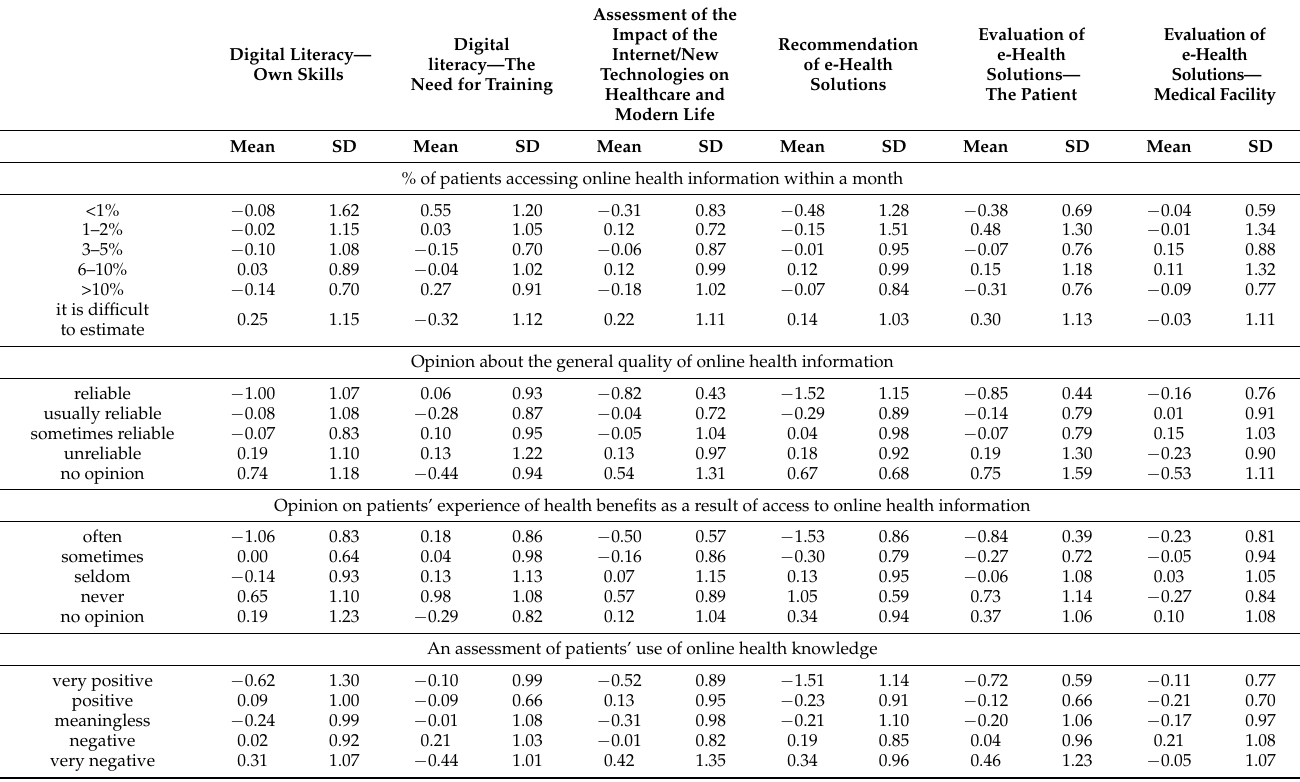
Table 5. Correlations between: % of patients accessing online health information within a month, Opinion about the general quality of online health information, and Opinion on patients’ experience of health benefits, as a result of access to online health information and digital and e-Health